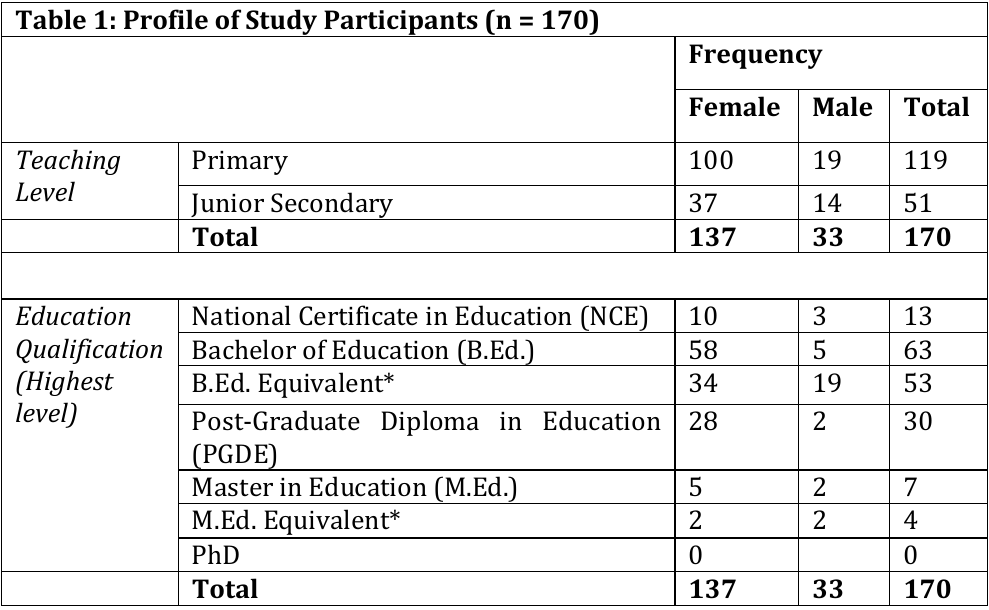
Table 1: Profile of Study Participants (n = 170)